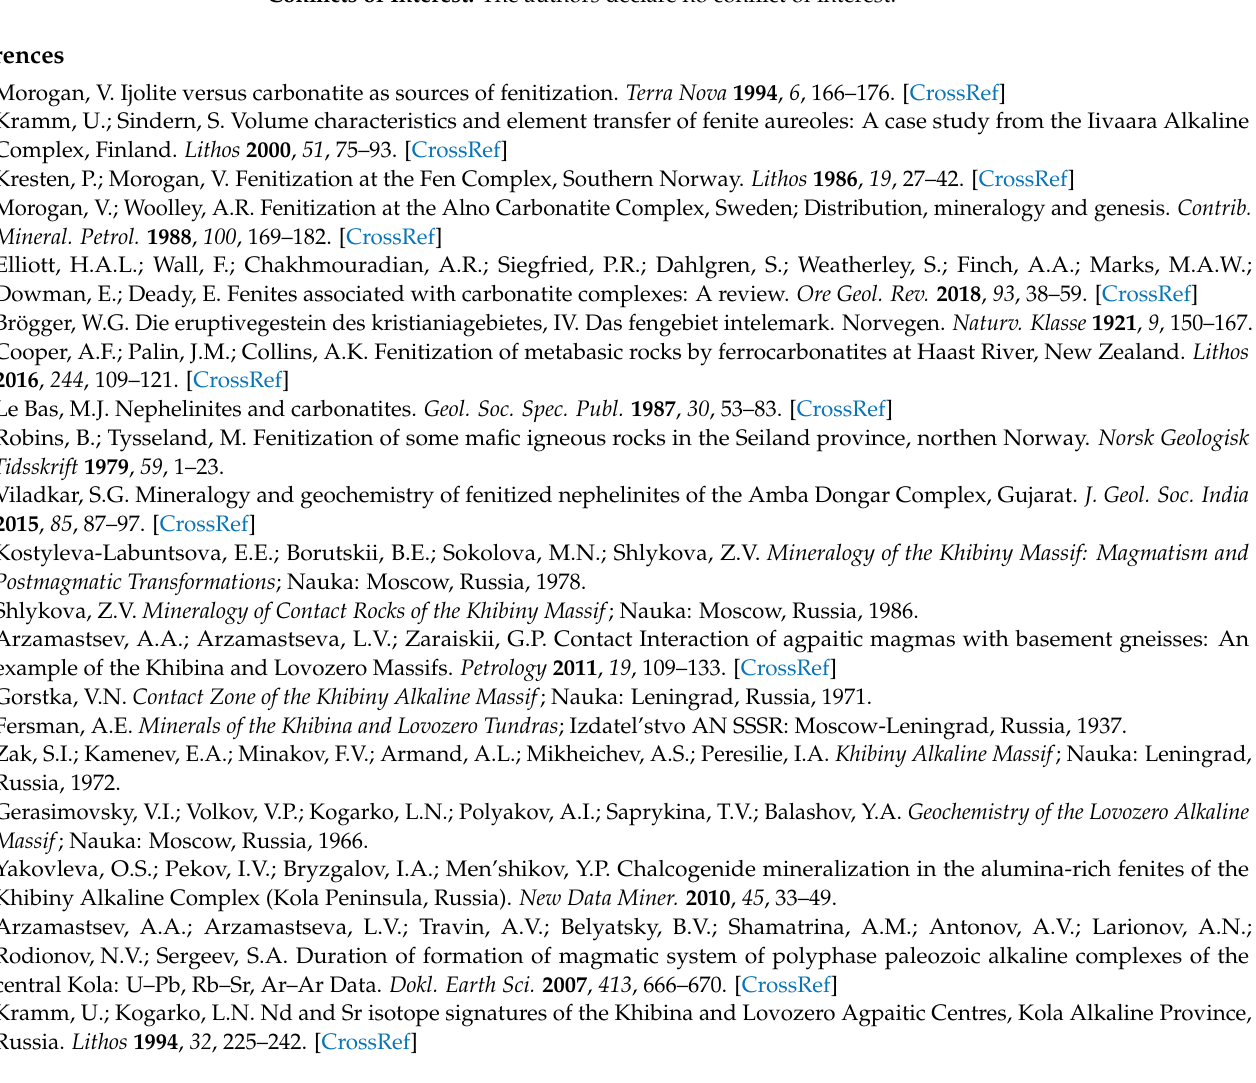
Table S6: Representative analyses of the fayalite; Table S7: Representative analyses of the garnets; Table S8: Representative analyses of the muscovite; Table S9: Major (wt.%) elements composition of the hornfelses; Table S10: REE (ppm)